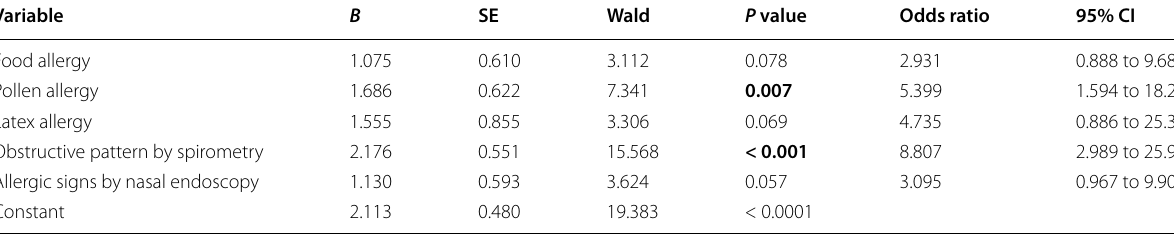
Table 4 Backward logistic regression analysis for predictors of eosinophilc